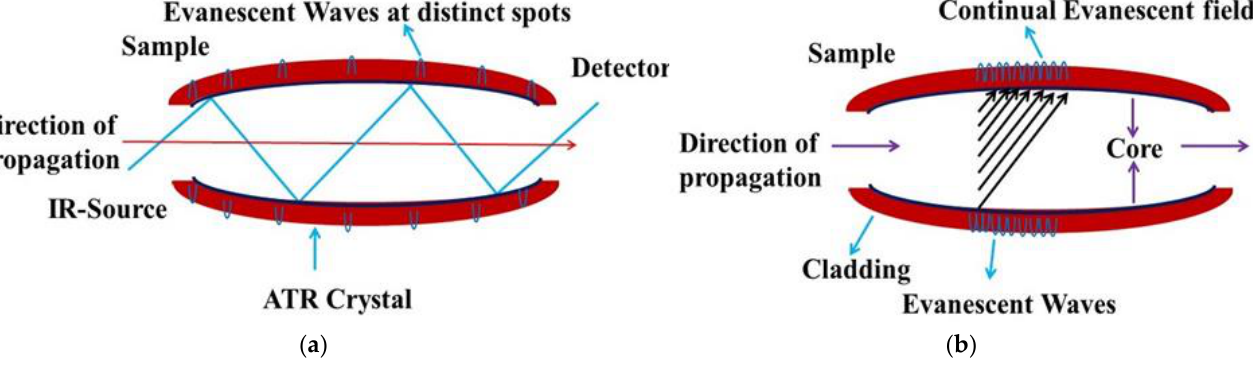
Figure 3. Graphical illustration of light propagation in an ( a ) ATR crystal and ( b ) optical wave-